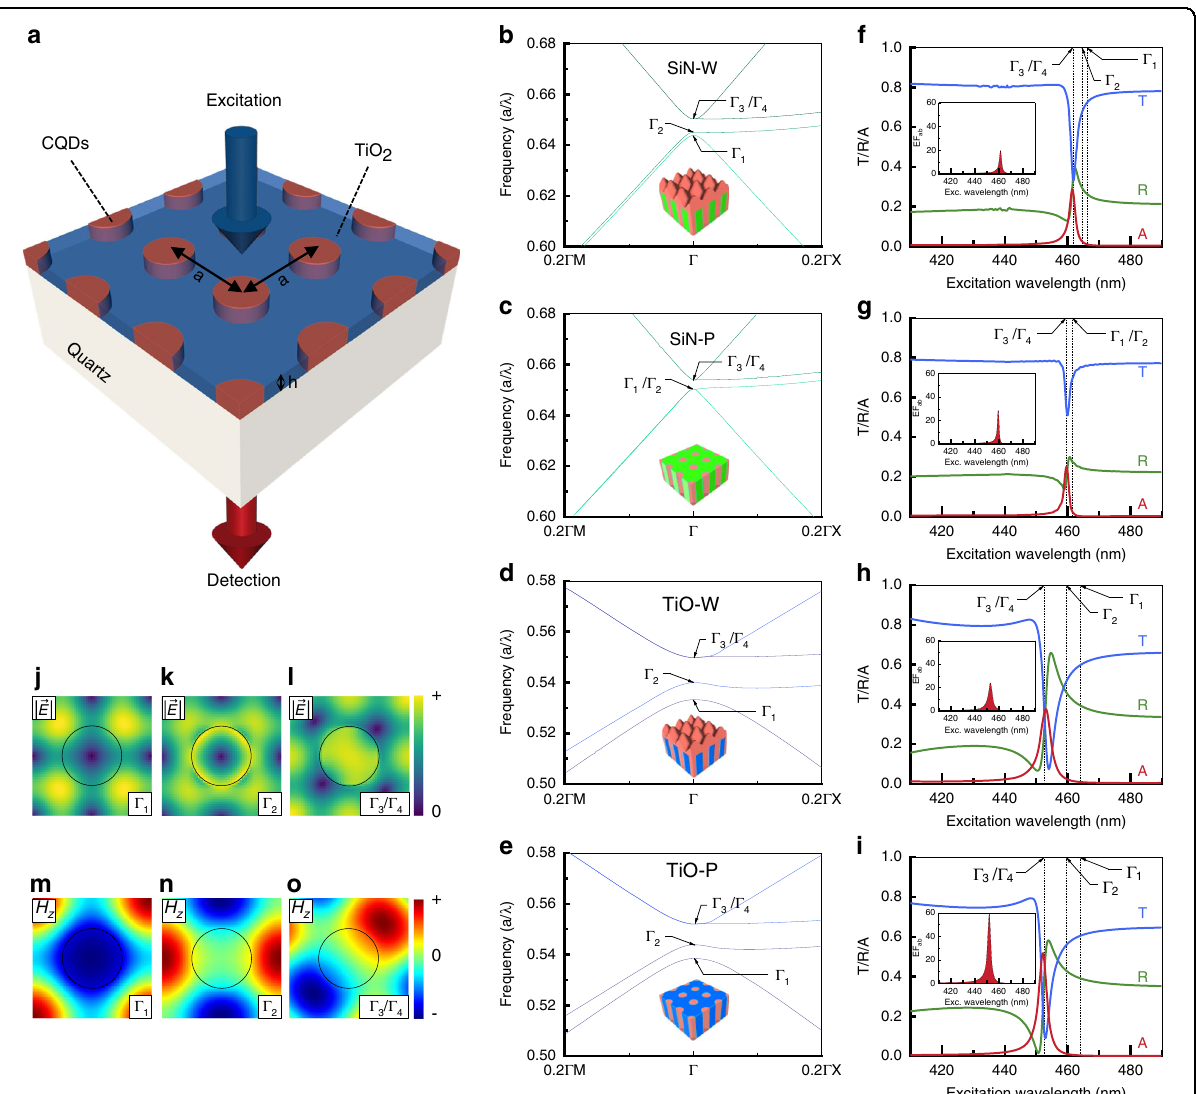
Fig. 1 CQD-based PhC phosphor with a TiO2 2D PhC backbone layer. a Schematic of the 2D PhC phosphor structure, with the schemes for excitation and detection indicated. b – e Photonic band structures calculated for b SiN-W, c SiN-P, d TiO-W, and e TiO-P. The inset in each fi gure is a schematic of the corresponding PhC phosphor platform. Both the Si 3 N 4 and TiO 2 fi lms are assumed to be 60 nm in thickness. f – i Calculated transmittance, re fl ectance, and absorbance spectra for f SiN-W, g SiN-P, h TiO-W, and i TiO-P. Insets show the calculated absorption enhancement factors for the corresponding PhC phosphor platforms. For direct comparisons, the wavelengths of the Γ -point band-edge modes determined from the band structures in ( b – e ) are identi fi ed. j – l Γ -point band-edge mode pro fi les ( E j j ¼ m – o Γ -point band-edge mode pro fi les ( H z ) calculated for TiO-P: m Γ 1 , n Γ 2 , and o Γ 3 / Γ 4 . The circles in ( j – o ) represent the air hole in the PhC unit